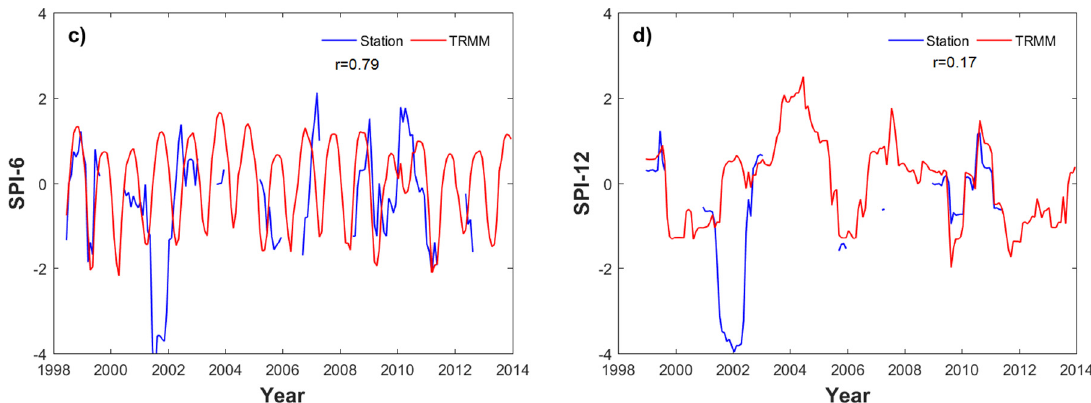
Figure 7. Comparison of SPI time series (TRMM-derived, blue line; Rain gauge derived, red line) at a temperate climate (Michoacán state in the central part of Mexico) for different timescales: one month ( a ); three months ( b ); six months ( c ); and twelve months ( d ). Pearson’s r correlation coefficient depicts the statistical agreement between both datasets.